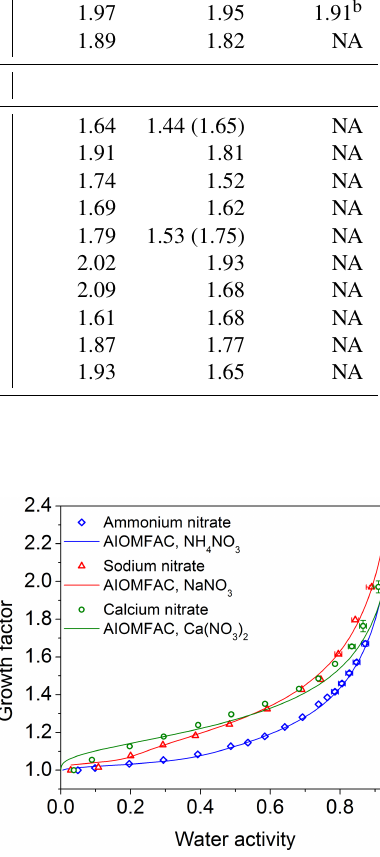
Figure 1. Hygroscopic growth factors of 100nm NH 4 NO 3 , NaNO 3 and Ca(NO 3 ) 2 particles as a function of water activity. The cor- responding AIOMFAC-predicted curve associated with measure- ments is also presented. The error bars representing the standard deviation of multiple measurements are generally not obvious com- pared to the size of the